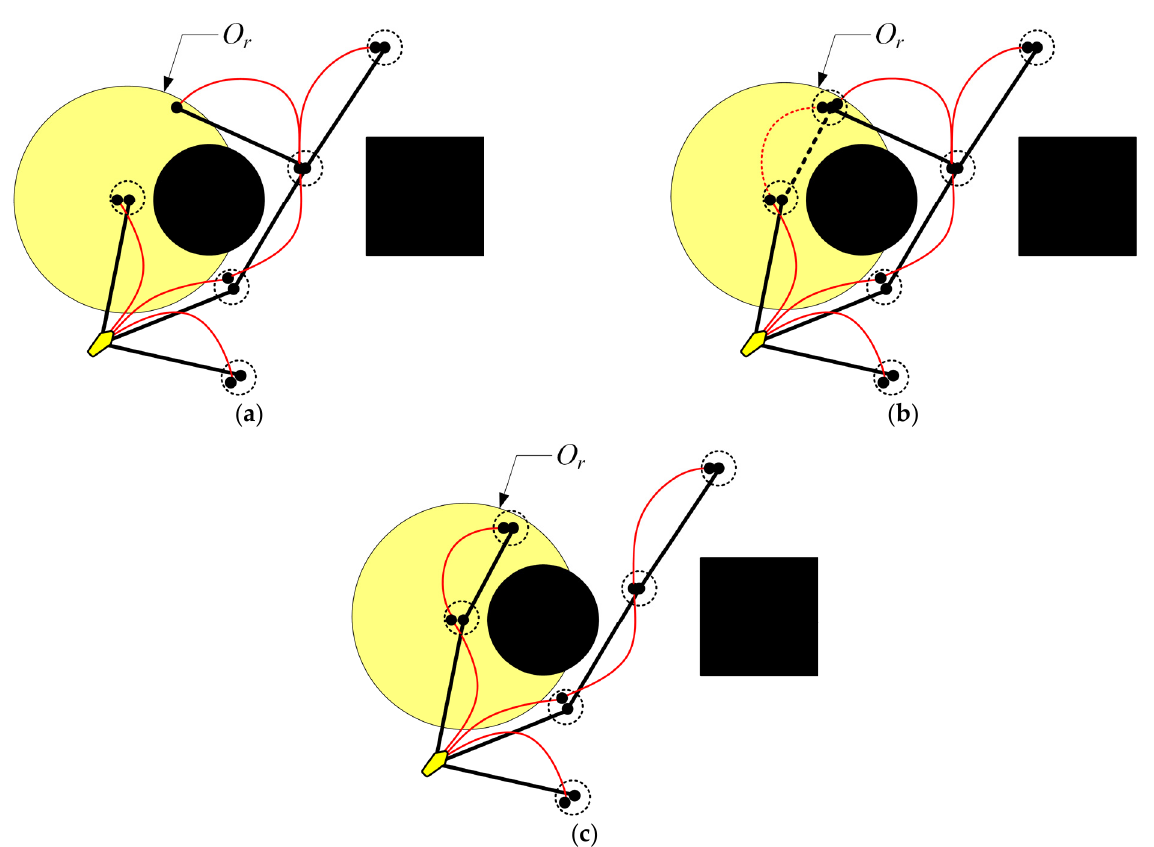
Figure 7. Optimization of two trees’ structures: ( a ) establishing an optimization region; ( b ) determining validity; ( c ) updating structures of T W and T S .